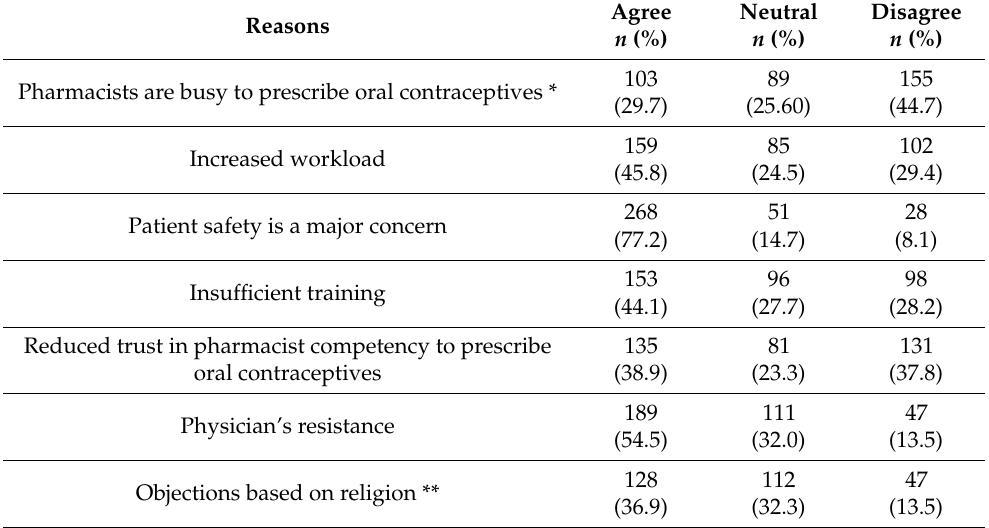
Table 6. Barriers that prevent CPs from prescribing oral